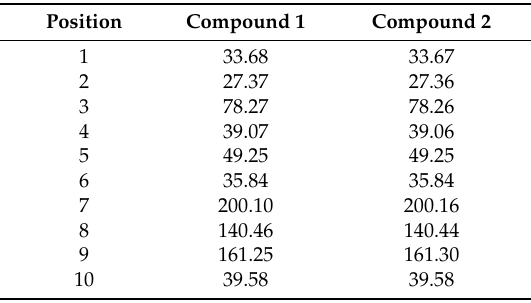
Table 2. 13 C-NMR data of compounds 1 and 2